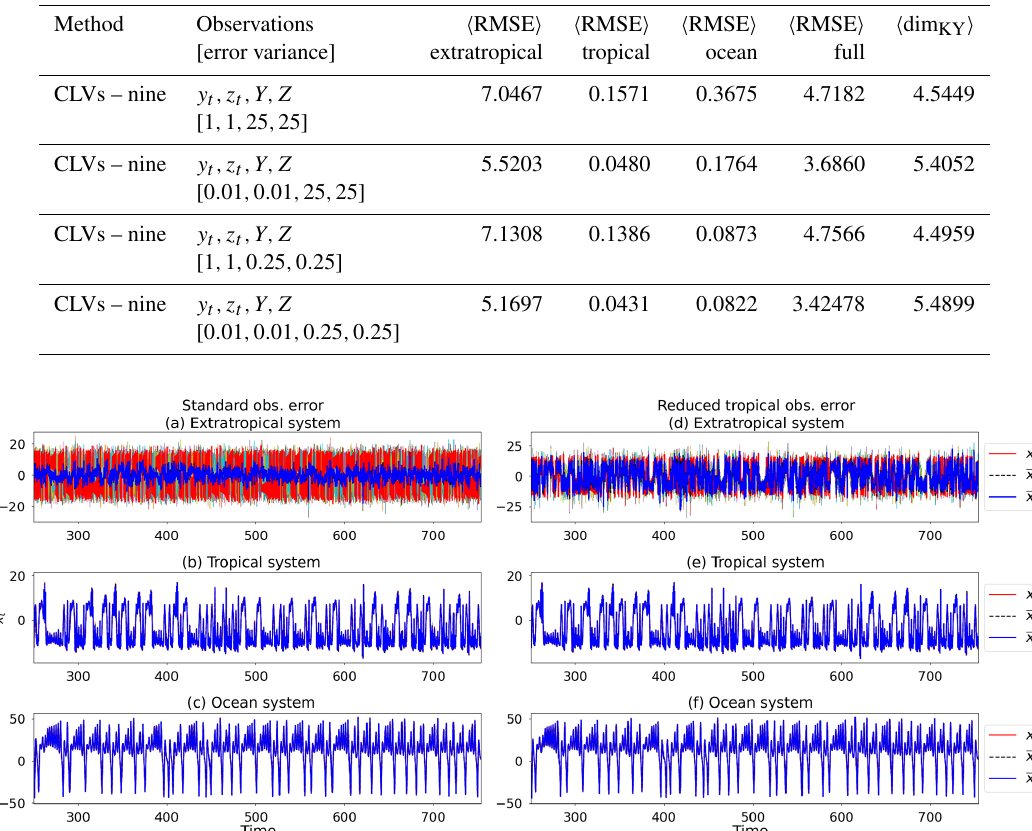
Figure 10. Trajectories of DA using nine CLVs, R = diag ( [ 1 , 1 , 25 , 25 ] ) (a–c) , and R = diag ( [ 0 . 01 , 0 . 01 , 25 , 25 ] ) (d–f) with ENSO obser- vations ( y t ,z t ,Y,Z ). Trajectories shown are control run (red), ensemble mean (blue), and individual ensemble members (multicoloured). For conciseness we only show the results for the x coordinate of each subsystem. The other two coordinates behave similarly. Parameters: assimilation window 0.08, inflation factor 1%, 10 ensemble